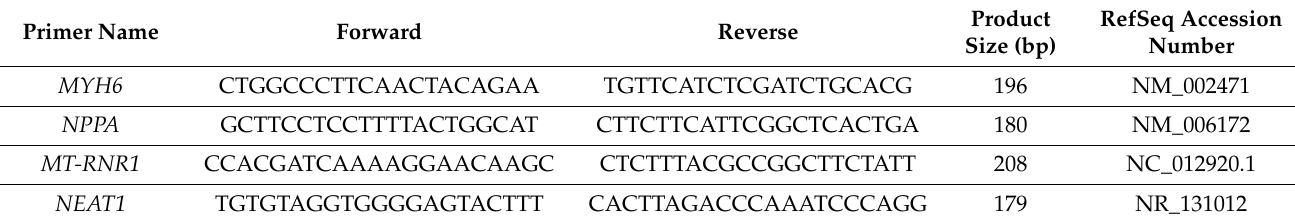
Table 1. Primers sequences for RNA-seq validation experiments.